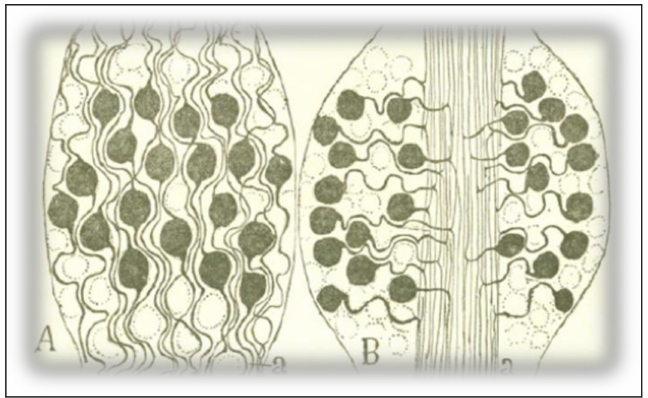
Figure 6. A scheme of the structure of spinal ganglia. ( A ): spinal ganglion of a fish (stingray); ( B ): spinal ganglion of a mammal (cat). Taken from Cajal [6] (p. 11); out of